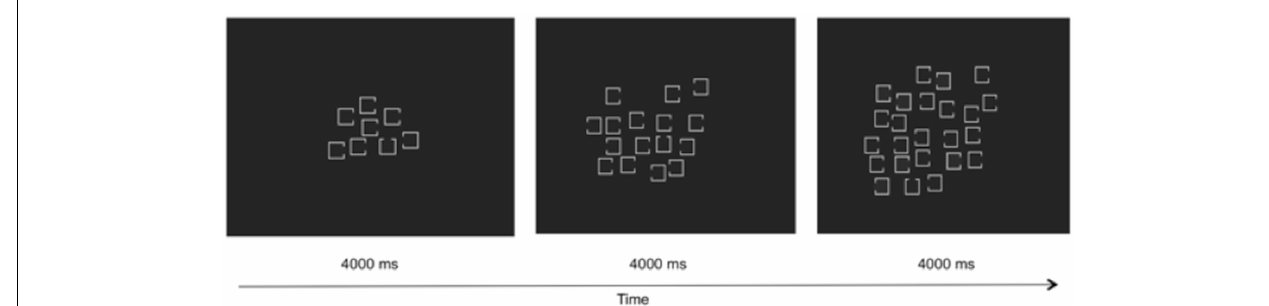
FIGURE 1 | Sample trials for visual search set sizes 8, 16, and